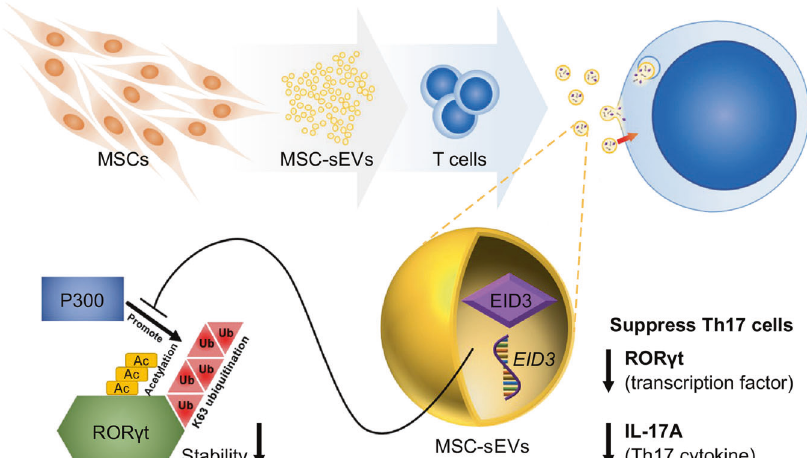
Fig. 6 Schematic explanation of the underlying mechanism of MSC-derived sEVs in Th17 cell suppression. ROR γ t is stabilized by K63 polyubiquitination and acetylation by p300. Eid3 derived from MSC-sEVs suppresses the K63-linked polyubiquitination and acetylation of ROR γ t by p300, resulting in proteolytic degradation of ROR γ t. As a result, MSC-sEVs inhibit ROR γ t expression and IL-17 production in Th17 cells. MSC-sEVs exert their therapeutic effects by degrading ROR γ t at the protein level, resulting in the depolarization of Th17 cells. From